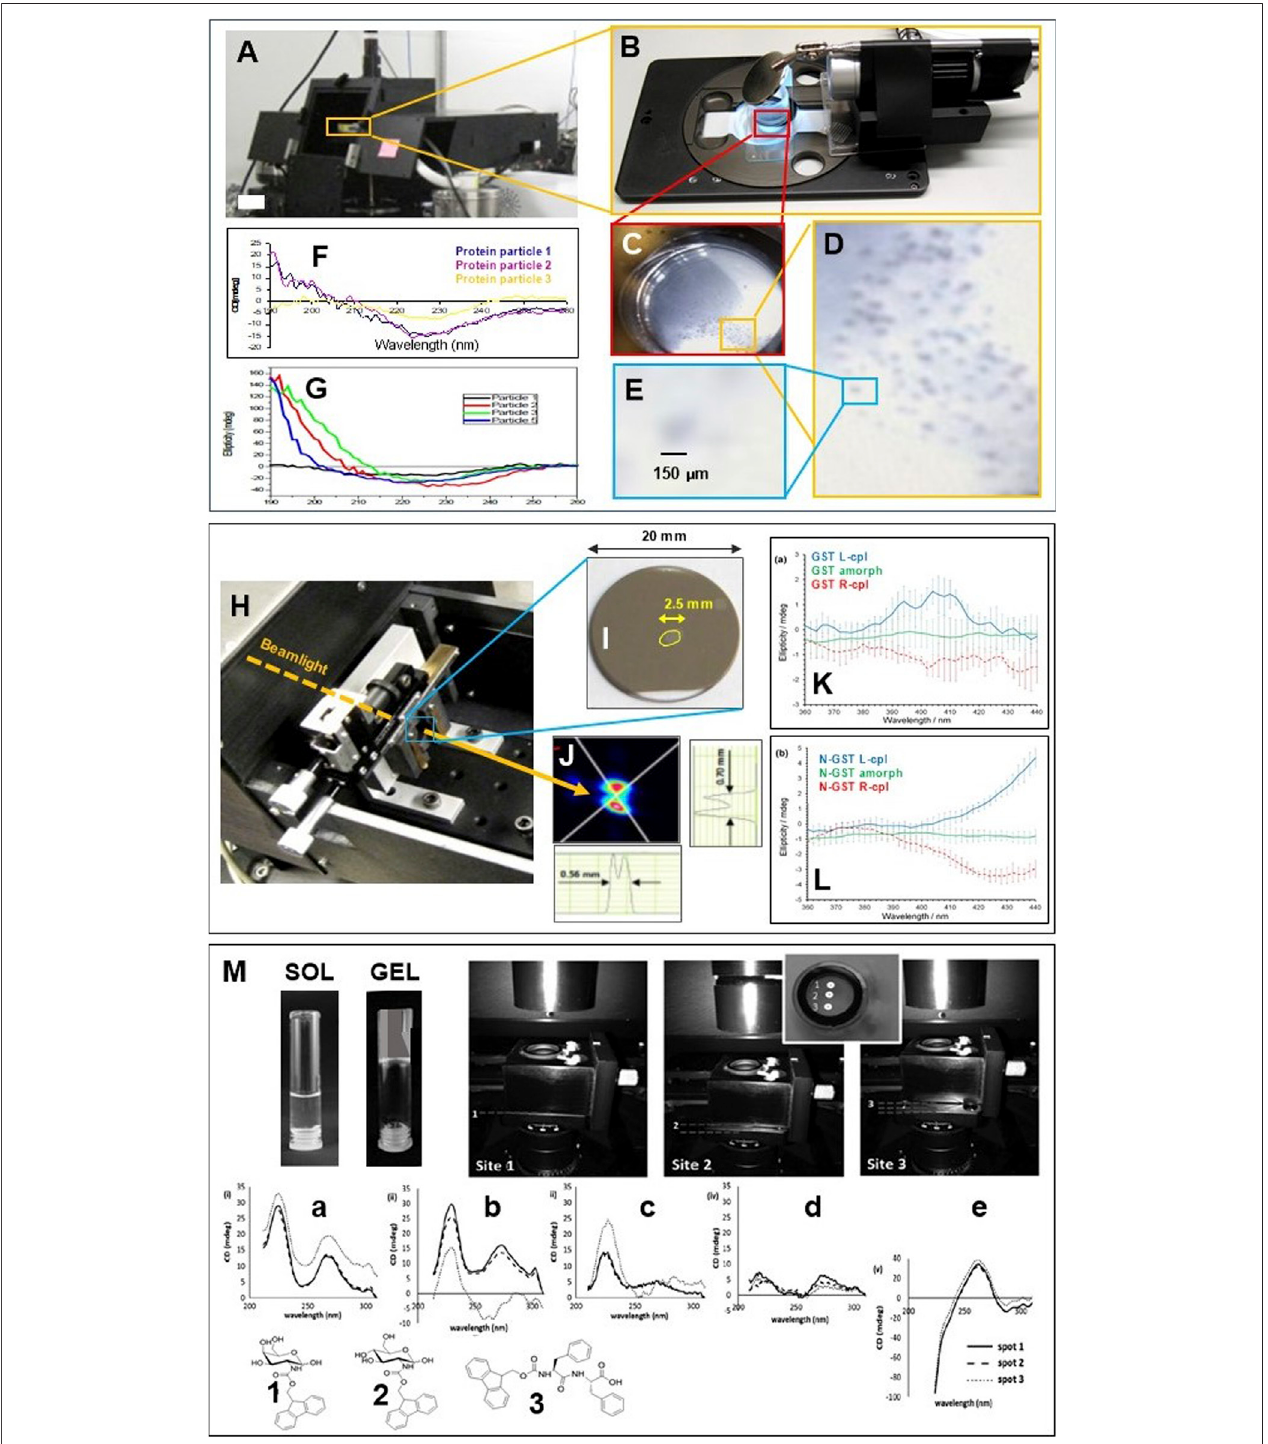
FIGURE 1 | (A) B23 vertical sample chamber of module A. (B) digital camera with mirror at 45 ° to view the cuvette containing a suspension of protein particles in a physiological solution. (C, E) zommed images of cuvette cell, particles and single particle with bar size of 150 μ m. (F) SRCD spectra of three selected particles of a β -sheetrichprotein(Redrawnfrom11). (G) adifferentpreparationofthesameproteinsof (F – H) X-YmechanicalstageenablesSRCDtobemeasuredatdifferentspotsof the GST yellow circled area investigated using the vertical chamber of B23 module B. (I) Fused silica substrate window coated with a thin fi lm of GST of which the spot of about 2.5 mm in length (circled in yellow for clarity) was sculpted with laser of left- or right-cpl. (J) Beamlight pro fi le of about 600 μ m in diameter at the GST